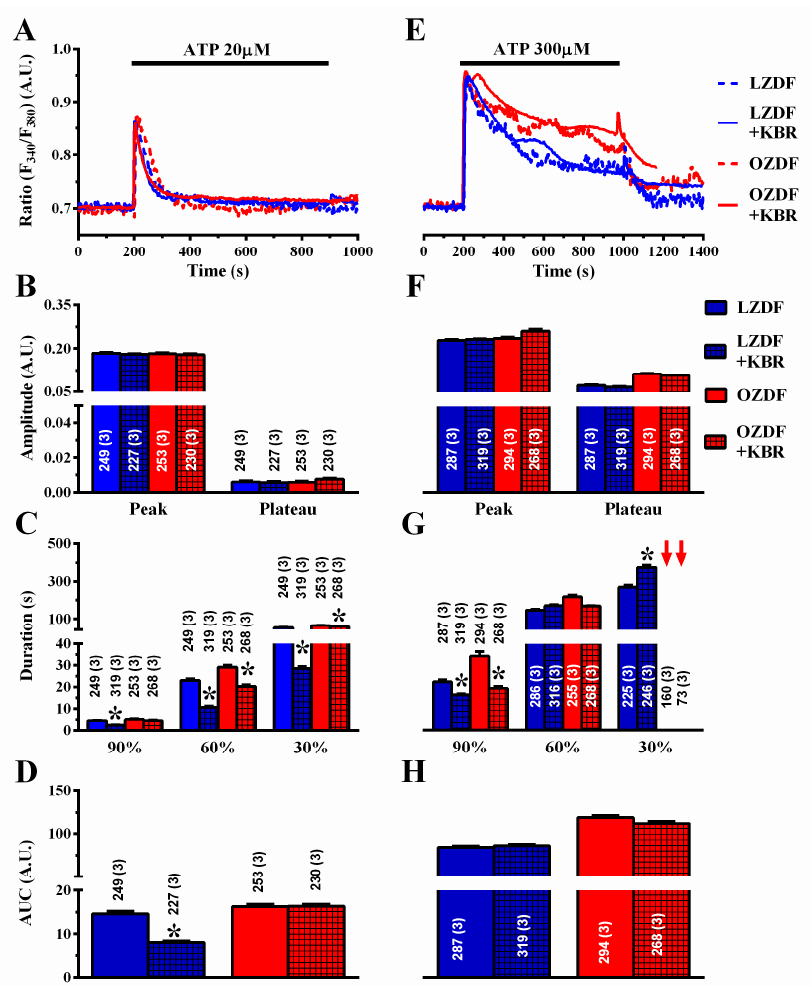
Figure 9. The effect of KB-R7943R on the Ca 2+ response to ATP is weakly altered in native aortic endothelium of obese Zucker diabetic fatty rats. ( A ) Representative recordings of the Ca 2+ response to 20 µM ATP in the absence or presence of 8 µM KB-R7943R (KBR) in native aortic endothelium of LZDF and OZDF rats. In KBR experiments, endothelial cells were preincubated for 300 s with 8 µM KBR. ( B ) Mean ± SE of endogenous Ca 2+ release and SOCE amplitude recorded in native aortic endothelium of LZDF and OZDF rats challenged with 20 µM ATP in the absence or presence of 8 µM KBR. ( C ) Mean ± SE of the duration of the Ca 2+ response to 20 µM ATP recorded in native aortic endothelium of LZDF and OZDF rats in the absence or presence of 8 µM KBR. ( D ) Mean ± SE of the AUC of the two distinct components (i.e., endogenous Ca 2+ release and SOCE) of the Ca 2+ response to 20 µM ATP recorded in native aortic endothelium of LZDF and OZDF rats in the absence or presence of 8 µM KBR. ( E ) Representative recordings of the Ca 2+ response to 300 µM ATP in the absence or presence of 8 µM KBR in native aortic endothelium of LZDF and OZDF rats. ( F ) Mean ± SE of endogenous Ca 2+ release and SOCE amplitude recorded in native aortic endothelium of LZDF and OZDF rats challenged with 300 µM ATP in the absence or presence of 8 µM KBR. The asterisk indicates p < 0.05. ( G ) Mean ± SE of the duration of the two distinct components (i.e., endogenous Ca 2+ release and SOCE) of the Ca 2+ response to 300 µM ATP in native aortic endothelium of LZDF and OZDF rats in the absence or presence of 8 µM KBR. The asterisk indicates p < 0.05. Red arrows indicate that the Ca 2+ signal failed to reach the clearing rate indicated in the graph in OZDF rats. ( H ) Mean ± SE of the AUC of the two distinct components (i.e., endogenous Ca 2+ release and SOCE) of the Ca 2+ response to 300 µM ATP in native aortic endothelium of LZDF and OZDF rats in the absence or presence of 8 µM KBR. The asterisk indicates p < 0.05, Mann-Whitney test.